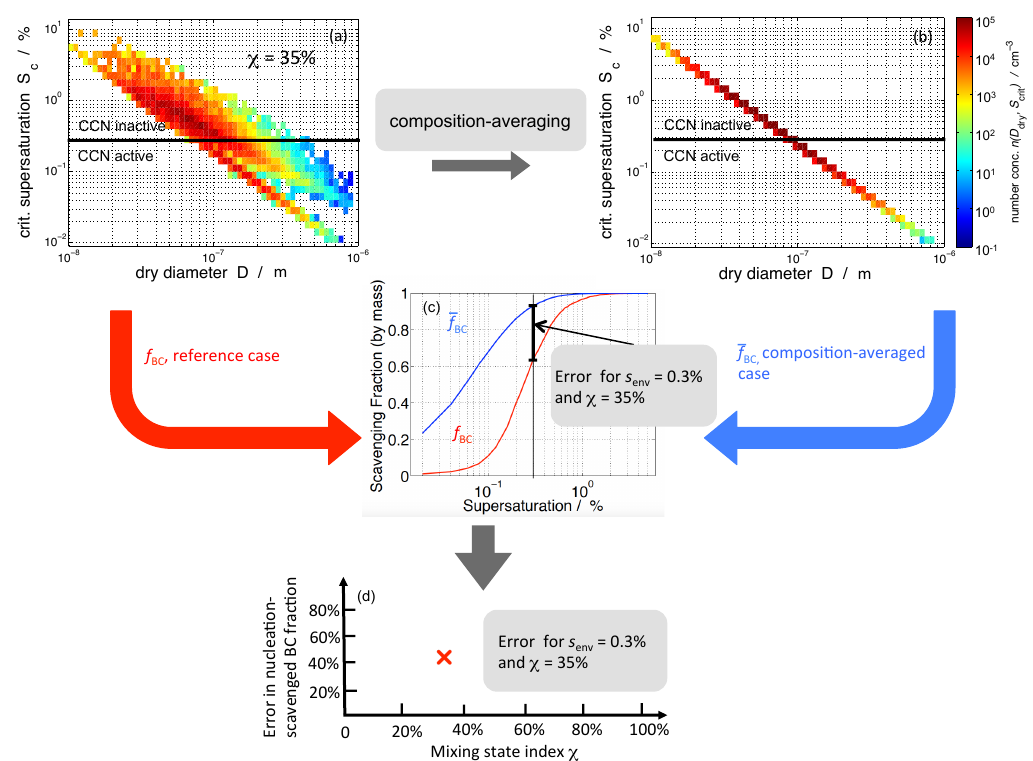
Figure 2. Conceptual framework for error quantification; see Section 2.3 for details. ( a ) ∂ 2 N ( D , s c ) / D ∂ s c for the reference case; ( b ) ∂ 2 N ( D , s c ) / ∂ log ∂ log 10 ( c ) resulting nucleation-scavenged black carbon mass fractions; ( d ) error in nucleation-scavenged BC fraction as a function of mixing